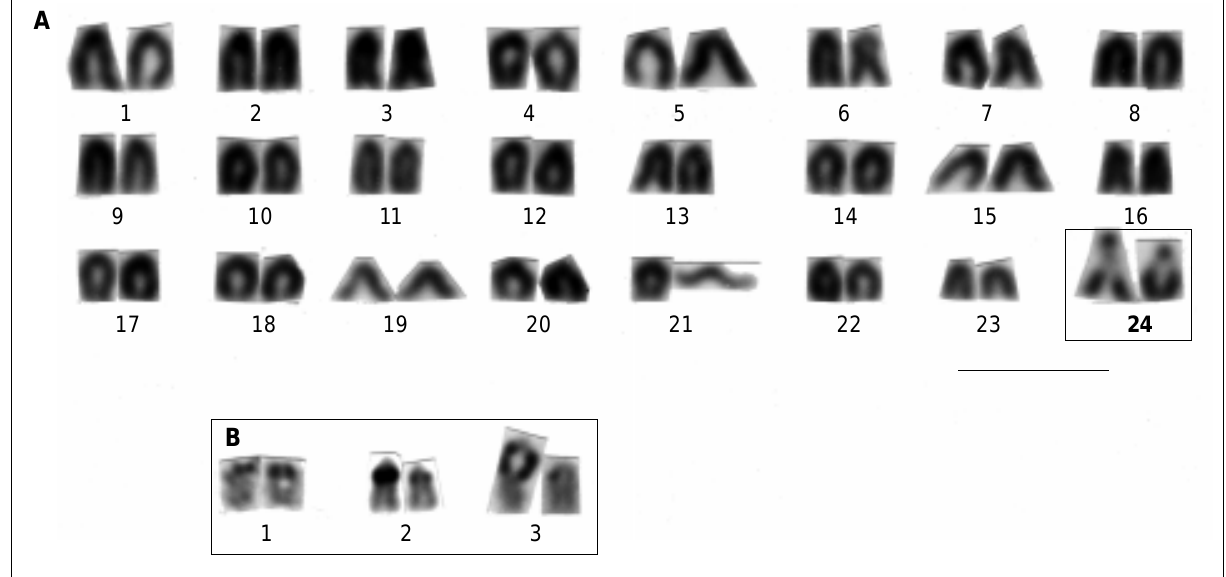
Figure 2 - Karyotype of Plagioscion squamosissimus. NOR-bearing chromosomes appear in the square inset as evidenced by Giemsa-staining (A) and silver nitrate (B). B1, B2, and B3 correspond to NOR heteromorphisms detected in Tefé River, Catalão Lake, and Pitinga River, respectively. Scale bar corresponds to 5 m m.